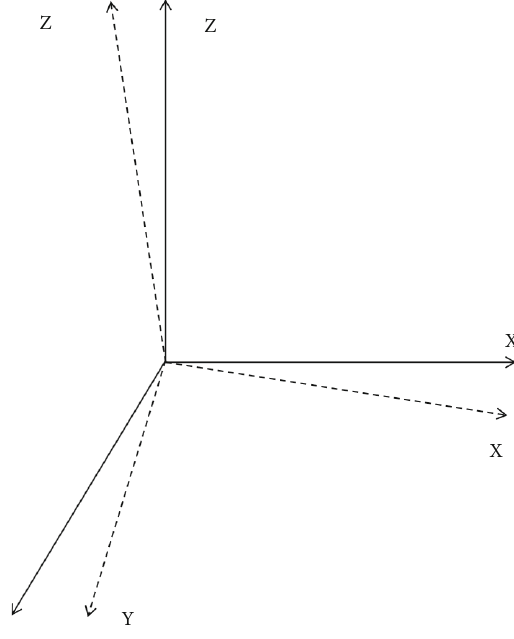
Figure 3: Direction of mobile phone sensor.